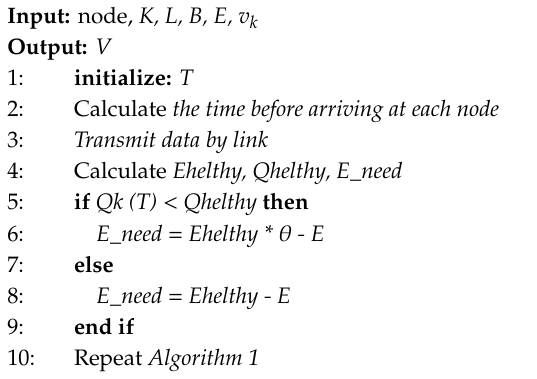
Algorithm 2: Speed